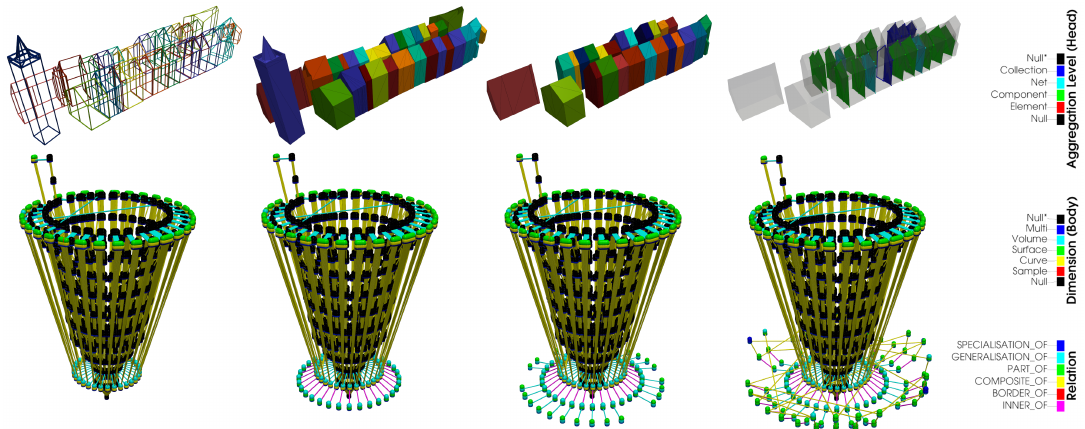
Figure 7. Geometries in first row from left to right: CityGML segment complexes colored by group, triangle complexes colored by group, resulting tetrahedron complexes from Algorithm 1 colored by ID, result of the inner overlay of each tetrahedron complex and their borders colored by aggregation level. Sequence of T 0 -space extensions in second row from left to right: CityGML (black) with the segment complexes (top green headed ring) and their grouping (bottom cyan headed ring), triangle complexes (outer bottom cyan headed ring), whole resulting T 0 -space after overlay.